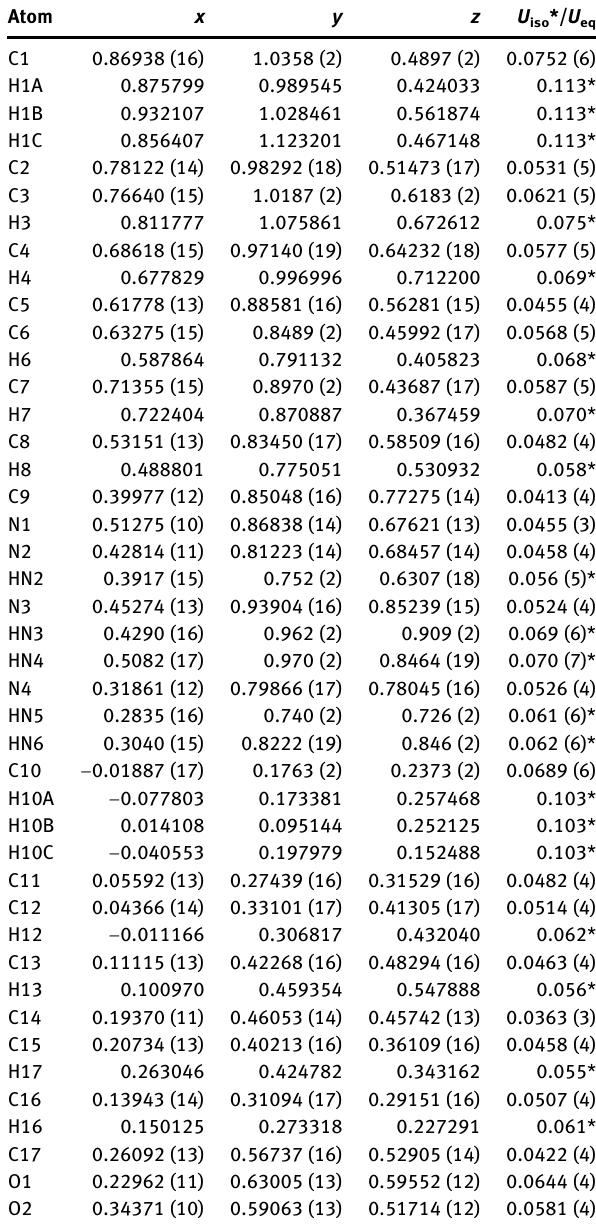
Table  : Fractional atomic coordinates and isotropic or equivalent isotropic displacement parameters (Å 